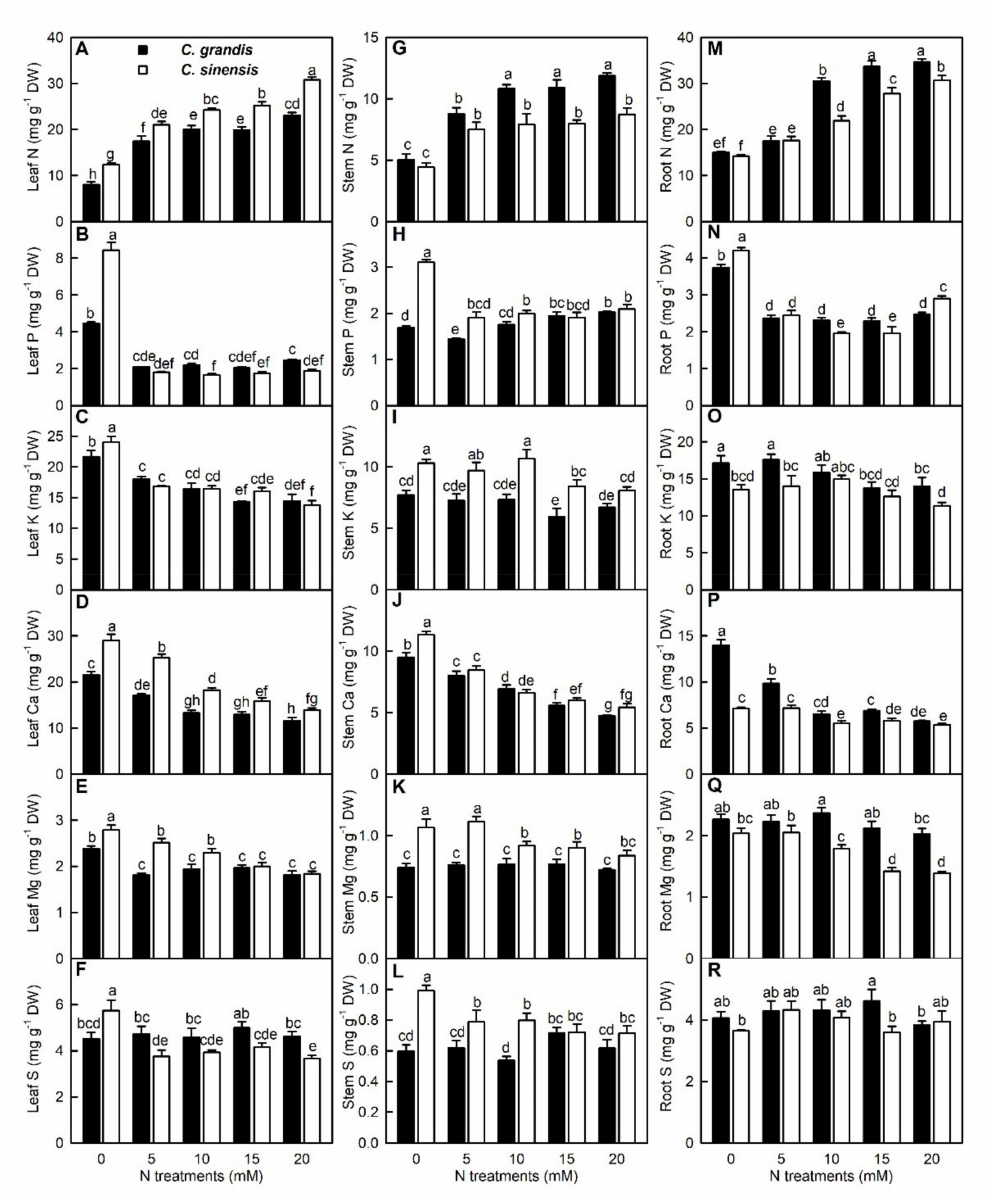
Figure 2. Effects of N supply on mean ( ± SE, n = 4) concentrations of N, P, K, Ca, Mg and S in leaves ( A – F ), stems ( G – L ) and roots ( M – R ). Fe concentration in C. grandis and C. sinensis roots and leaves, and C. grandis stems decreased or remained stable with increasing N supply with the only exception that Fe concentration in C. grandis leaves was higher at 15 mM N than at 10 and 20 mM N, while its concentration in C. sinensis stems increased or remained unchanged with increasing N supply. The concentrations of Mn and Zn in C. sinensis roots, stems and leaves, Zn in C. grandis leaves, and Cu in C. grandis and C. sinensis leaves increased as N supply